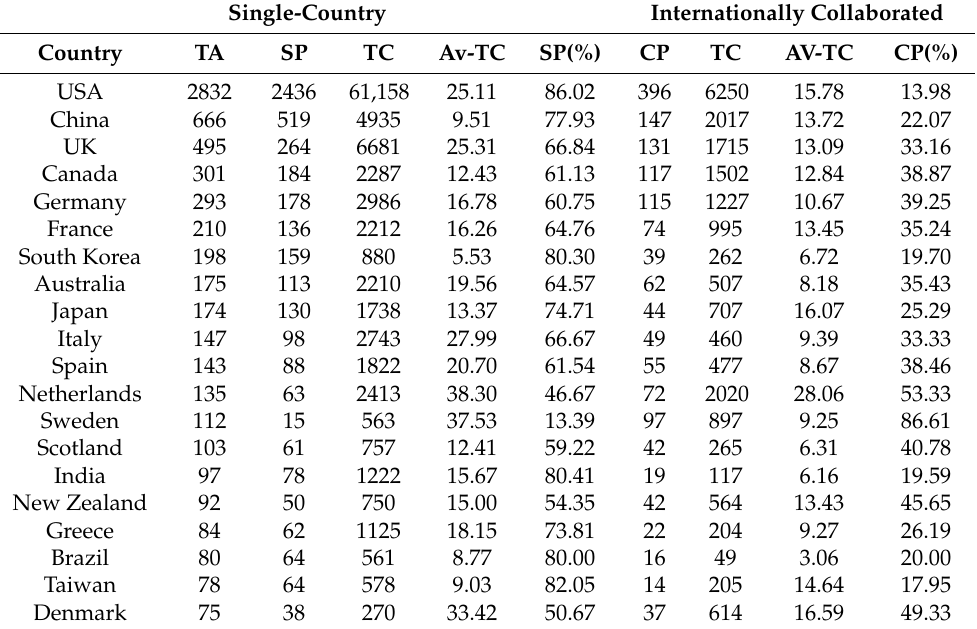
Table 4. The top 20 countries in the world that publish the most articles on NPS. Single-Country